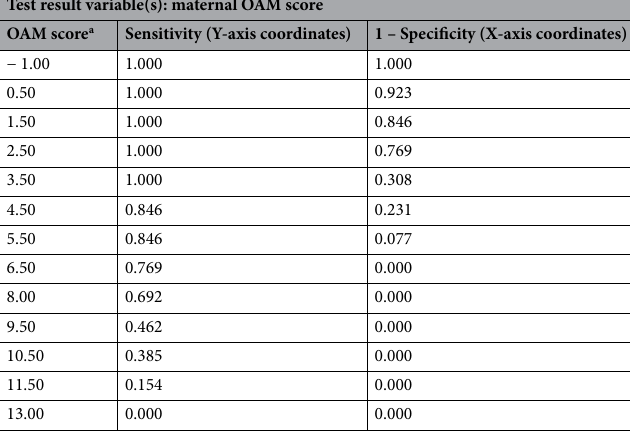
Table 10. Sensitivity and 1-specificity values at different AMS, calculated on the basis of the ROC curve (Coordinates of the curve) in maternal GP-GC kinship analysis by X-STR. The smallest OAM cutoff score value is the minimum observed test value minus 1, and the largest cutoff value is the maximum observed test value plus 1. All the other cutoff values are the averages of two consecutive ordered observed test values.